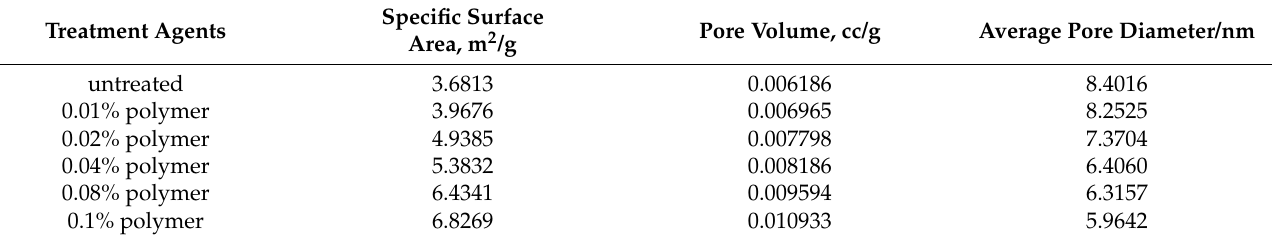
Table 2. The pore structure of